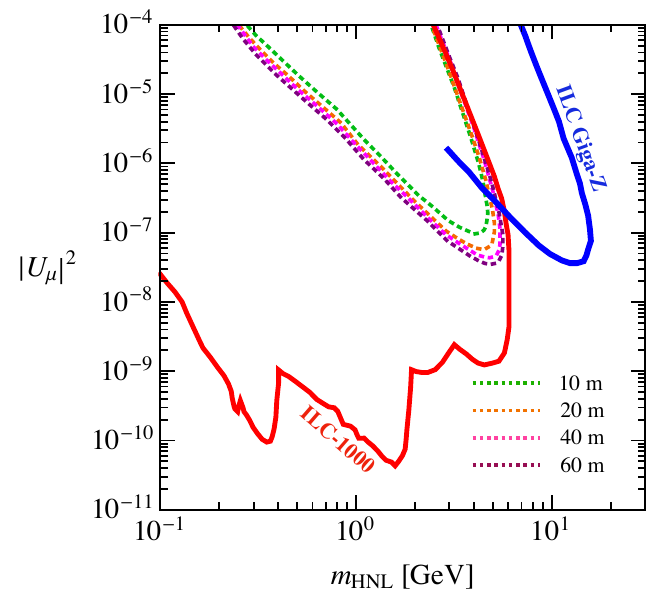
Figure 12 . The colored dotted curves correspond to three signal events with 10-year statistics for the DIS process. We assume the signal events are the HNL decays inside the decay volume except for HNL → νν ¯ ν . The results for the different lengths of the muon lead shield, 10 , 20 , 40 , 60 m are compared. The red curve shows the expected 95% C.L. exclusion sensitivity with 10 -year statistics for the HNL productions from the SM particle decays. The blue curve corresponds to the sensitivity of the Giga-Z program at